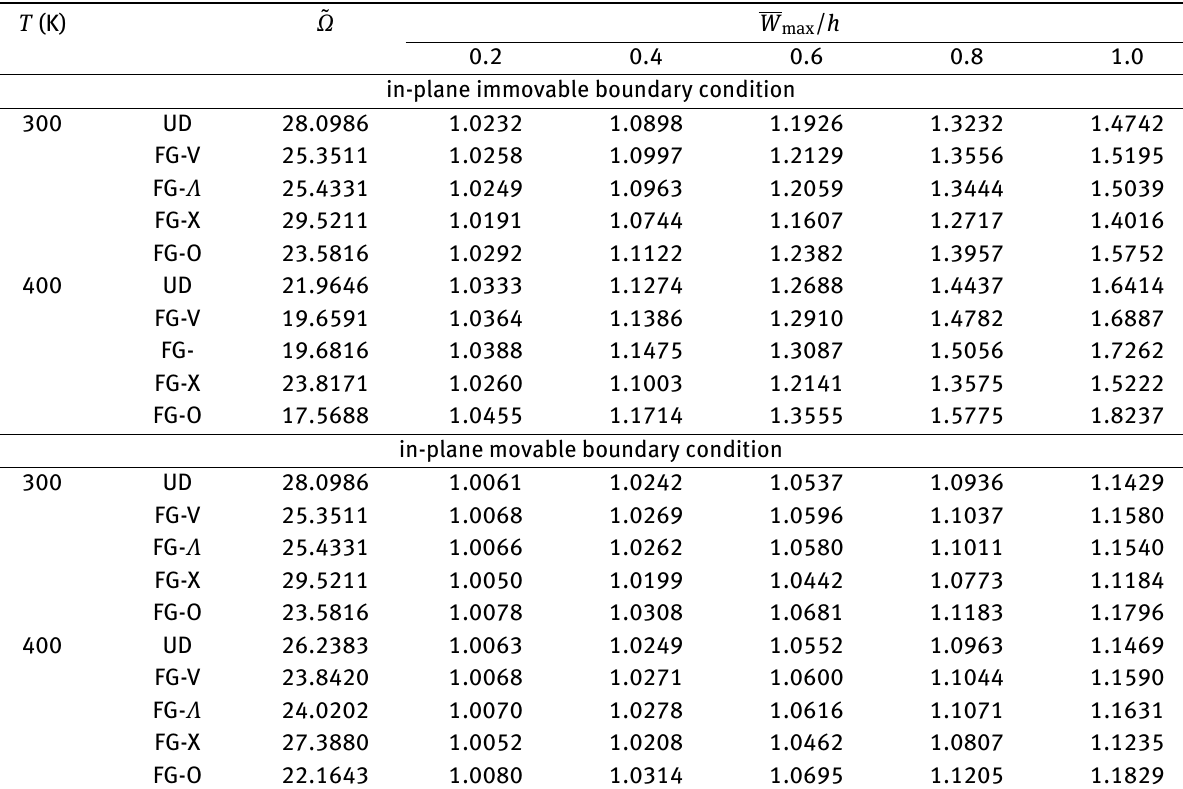
Table 7: Effects of end condition on the nonlinear to linear frequency ratios ω NL / ω L for double curved (0/90/0/90/0) S GRC laminated panels in thermal environments ( a/b = 1, b/h = 10, h = 2 mm, a/R 1 = b / R 2 =